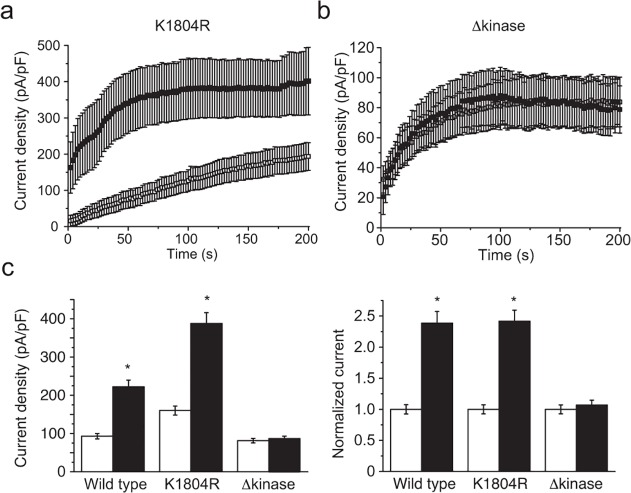
The presence of the intrinsic alpha-kinase domain of the channel but not its activity is required for flavagline-mediated stimulation of TRPM6.
a. The average time-course of current development of the kinase-inactive channels (TRPM6K1804R) with (n = 7, full symbols) or without (n = 9, empty symbols) FL23 (50 nM) pre-incubation is shown for current values measured at +80 mV. b. The average time-course of current development of TRPM6L1749X (Δkinase) with (n = 8, full symbols) or without (n = 9, empty symbols) FL23 (50 nM) pre-incubation is shown for current values measured at +80 mV. c. Pre-incubation of cells with FL23 (50 nM) stimulated wild type (n≥22), K1804R (n≥9), but not Δkinase (n≥8, p>0.05) channel activity. Right panel shows current values normalized to each control condition. Stars indicate statistically significant difference (P<0.05) between vehicle- (white bar) and compound-treated cells (black bar).